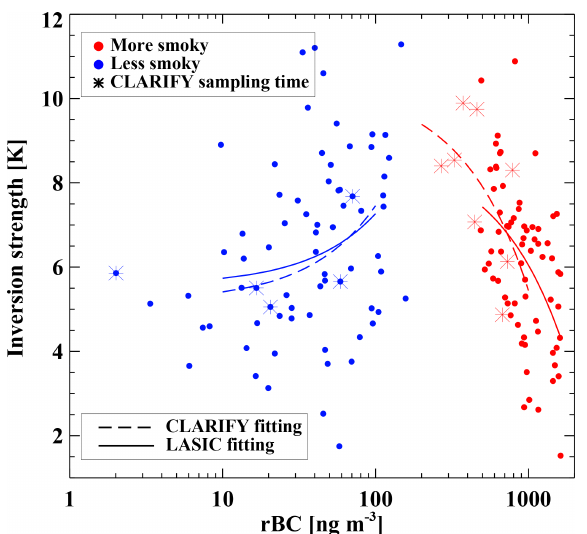
Figure 16. Radiosonde-derived inversion strength as a function of the refractory black carbon mass concentrations, with “more” (red) and “less” (blue) smoke loading days indicated. Radiosonde- derived inversion strength values for the UK CLARIFY aircraft sampling periods are indicated as asterisks using the same color code. Linear fits are included for the two composites and the two campaigns. Note the logarithmic x